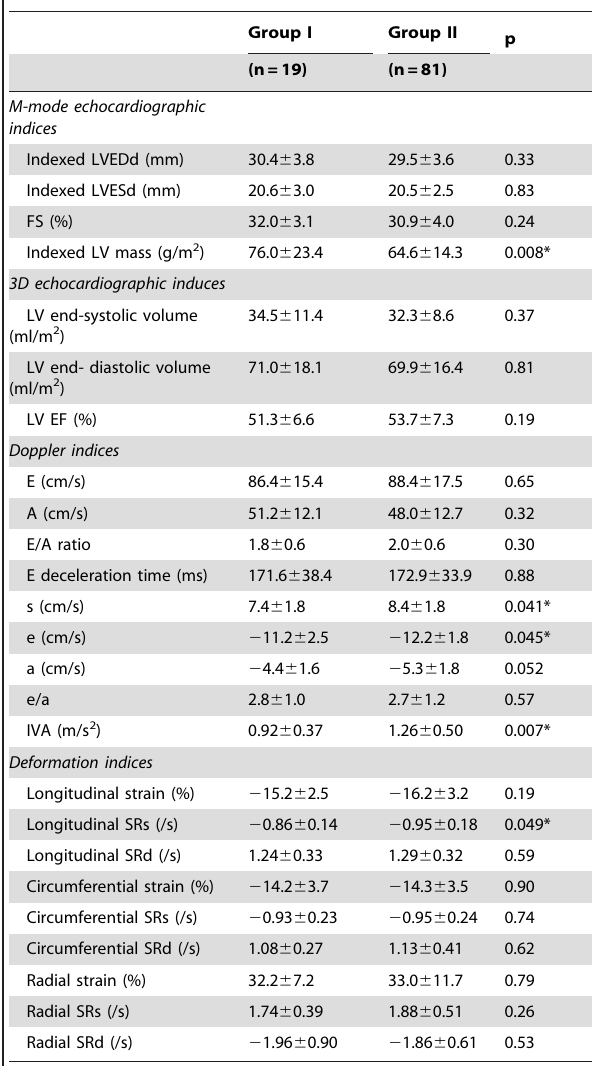
Table 4. Comparisons of echocardiographic findings between survivors with (group I) and without (group II) elevated hs-cTnT levels.